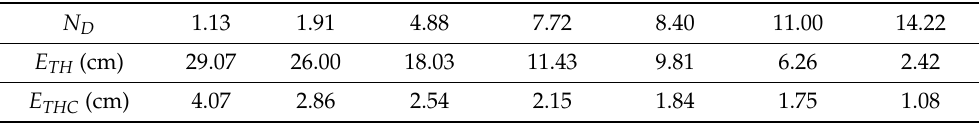
Table A2. Accuracy results with different echo signal intensities.